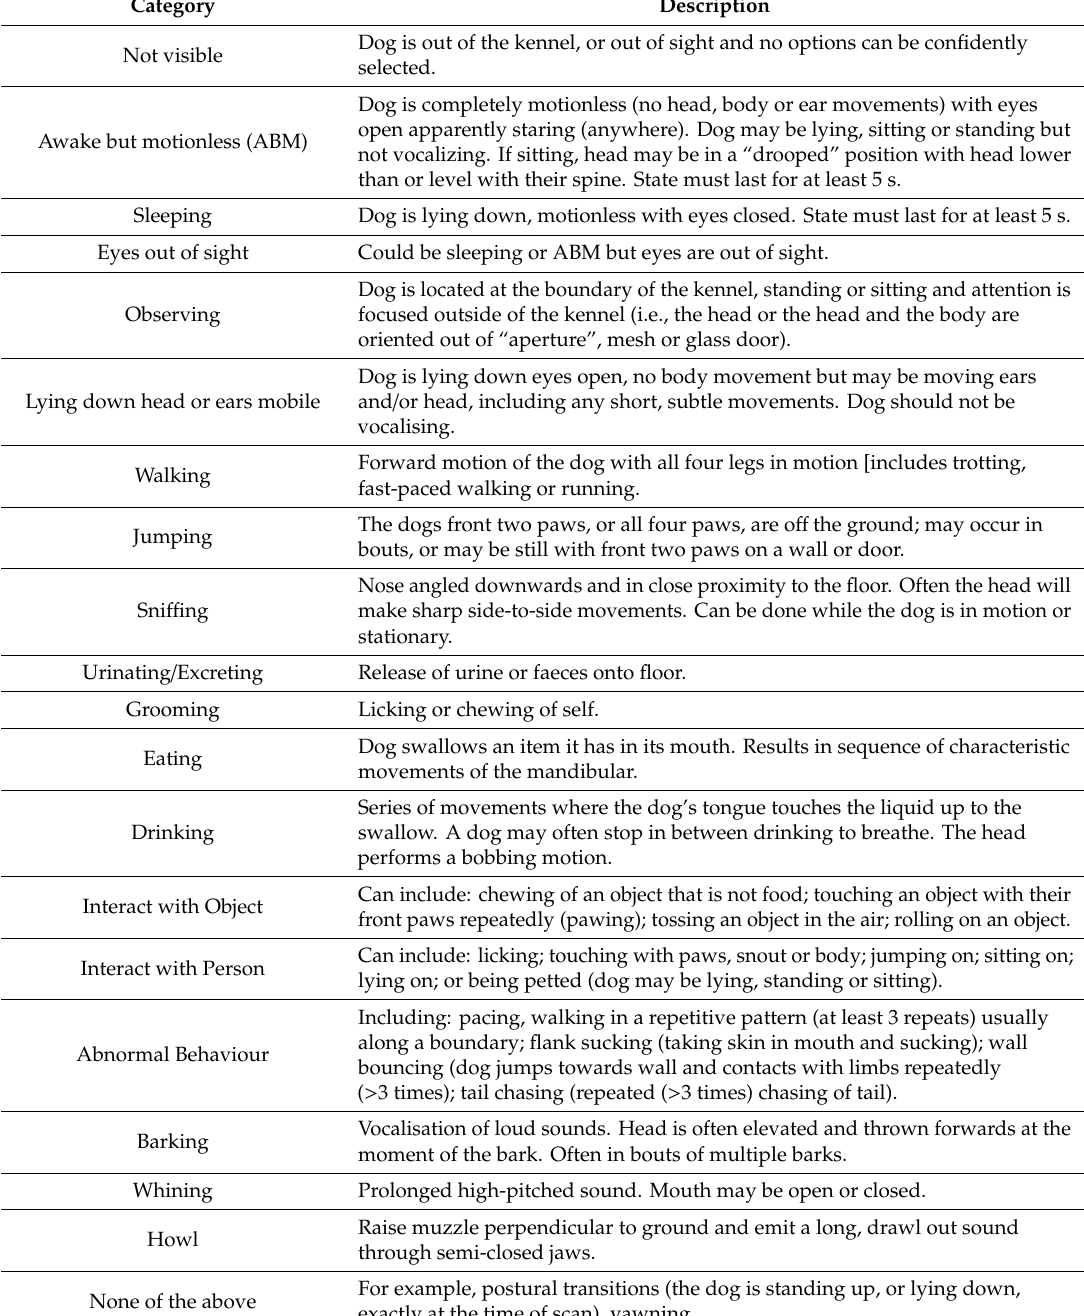
Table 2. Ethogram for determination of activity budgets of dogs in their home pen (adapted from previous studies [23,31,35,44–47]). Note that eye invisibility when the dog is scored “Eyes out of sight” does not allow for determination of the correct action (e.g., sleeping, or awake but motionless), which would impair any interpretations of the results; consequently, no subsequent analyses were performed on this